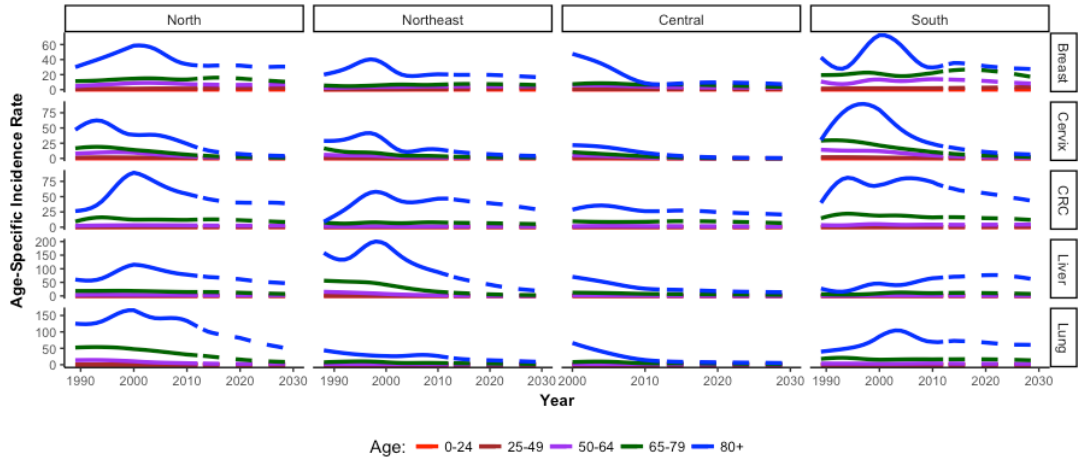
Figure 8. Age-specific incidence rates for each cancer in females only by region. Note the Y -axis are different for each cancer.